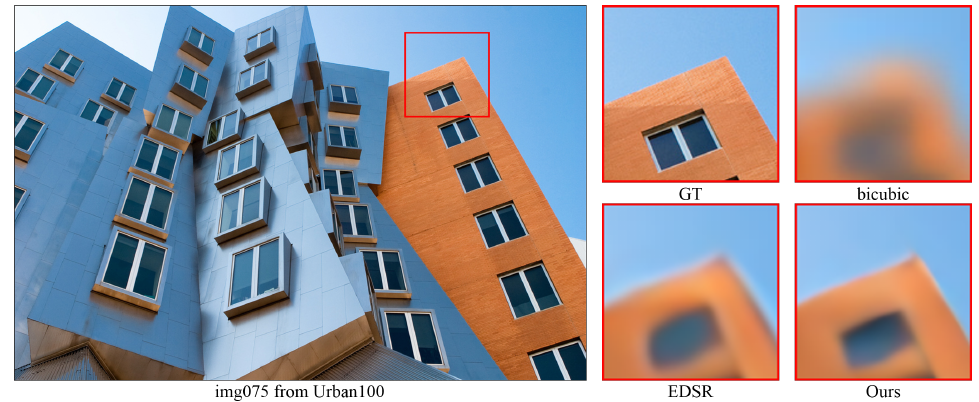
Figure 1. The super-resolution reconstruction results of different methods for × 32 magnification.